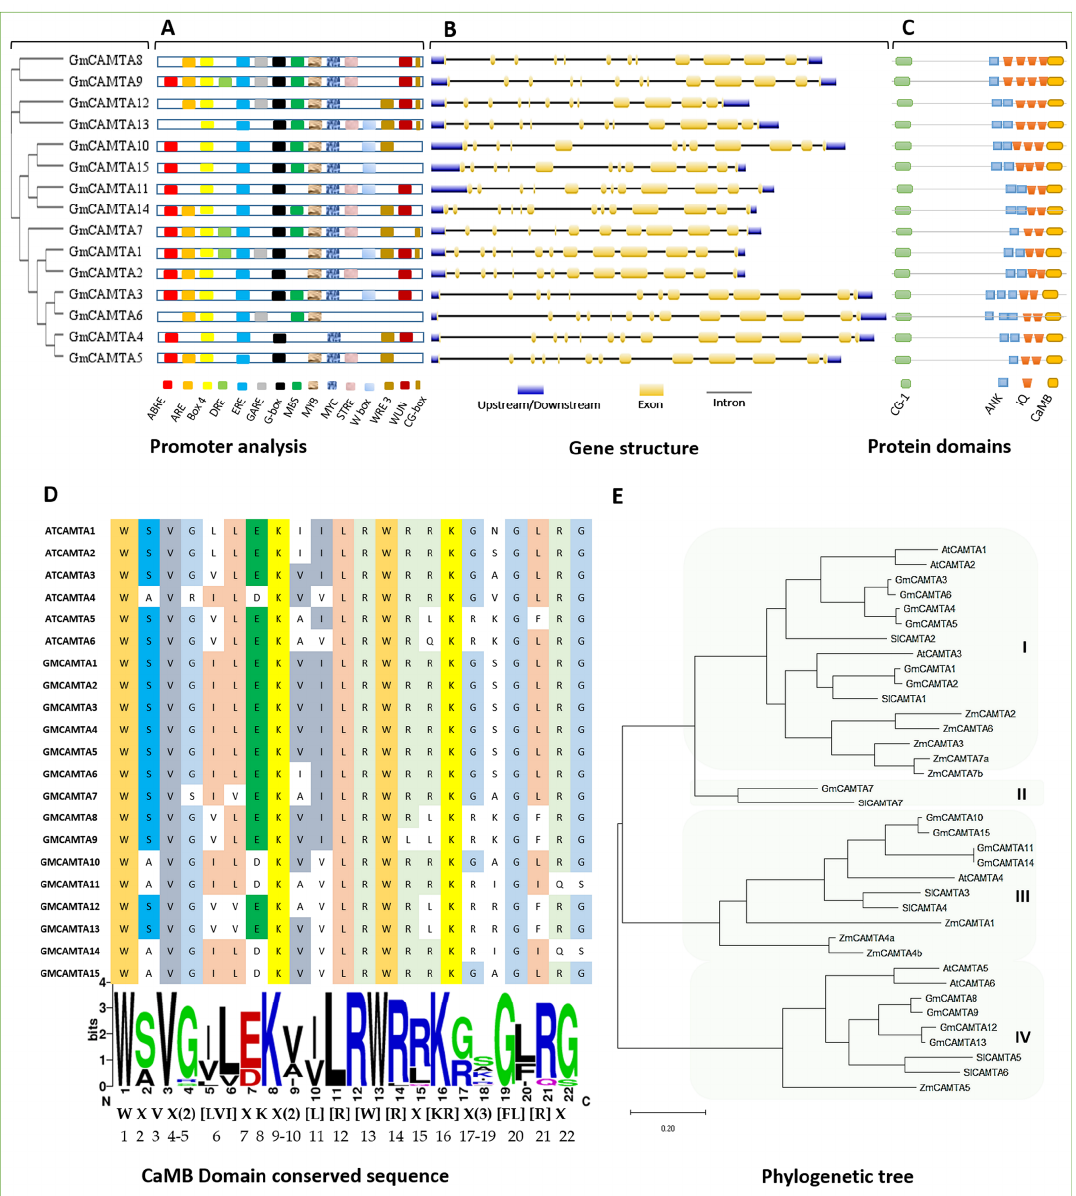
Figure 1. Comprehensive in silico analysis of the GmCAMTA family. ( A ) Cis -elements in the GmCAMTA promoter region. Each type of cis -motif present in GmCAMTA promoters is shown in unique color/color pattern. ( B ) Exon-intron assembly of GmCAMTA genes. ( C ) Domain organization of GmCAMTA proteins. Four different domains are represented in different colored shapes. ( D ) Alignment showing the conserved motif sequence of the Calmodulin Binding Domain of Arabidopsis and Soybean CAMTA TFs. Each conserved residue at the definite position along the row (throughout the orthologues) is shaded in unique color. The functional residues in CaMB domain of these CAMTAs are indicated in the motif below the alignment. In the square brackets “[ ]” are the amino acids allowed in this position of the motif; “X” represents any amino acid and the round brackets “( )” indicate the number of amino acids. ( E ) ML (maximum likelihood) phylogenetic tree.